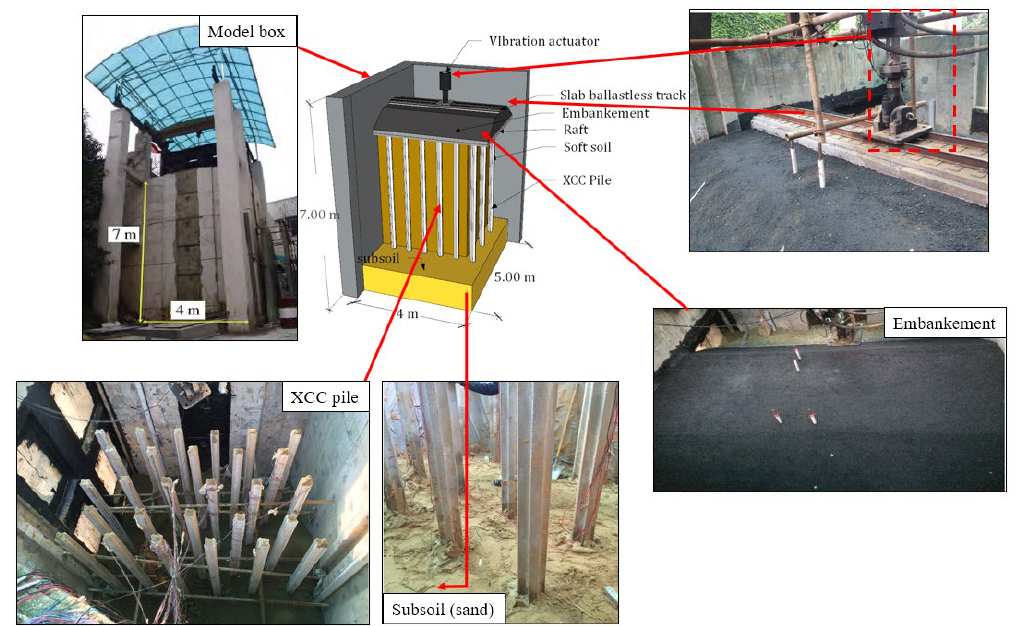
Figure 1. Physical model of ballastless track embankment and XCC pile–raft foundation. The schematic arrangement of the velocity and soil pressure sensors used to record the vibration velocity and soil pressure is shown in Figure 2a,b. Velocity sensors (V1 – V12) were placed in various locations along the horizontal and vertical directions.